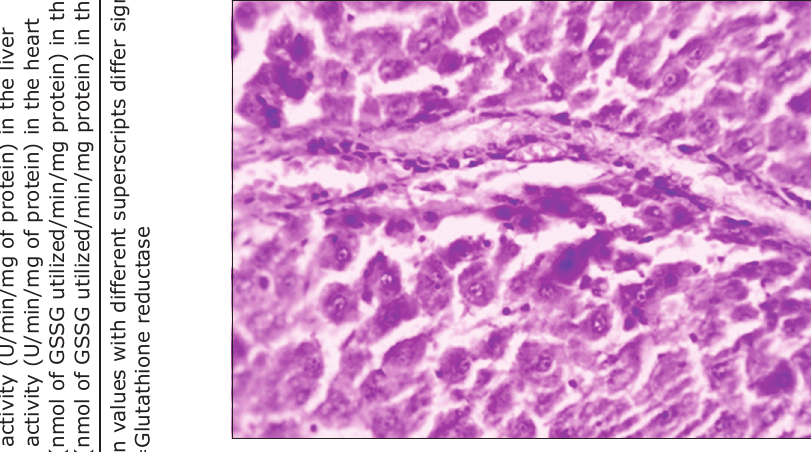
Figure-4: Group III liver showing proliferated endothelial cells forming vascular channels (H and E,